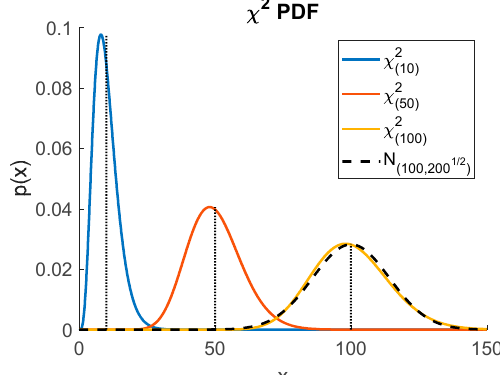
Figure 12. Three χ 2 distributions for an increasing number of dofs. The χ 2 is compared to the asymptotical tendency distribution 𝑁 . The asymptotical means are highlighted as black dotted lines. Notice that increasing the dofs, the distribution concentrates around the asymptotical mean.